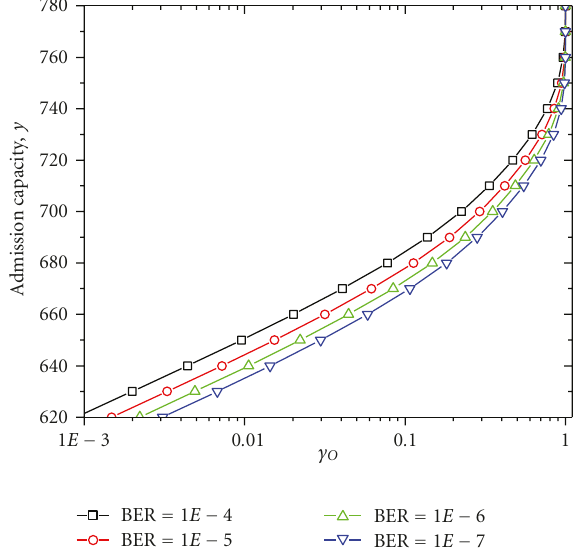
Figure 6: The maximum number of connections y versus γ O with = 50 mW, σ 2 = 10 − 11 , φ = 100Kbps, BER = 1 e − 5). ( p respect to p s r